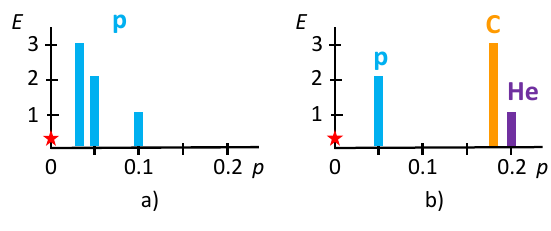
Figure 1. One dimensional sketch of a) an only energy depen- dent multiplet structure of protons with 1 / E deflection behavior and of b) a mixed composition multiplet structure where the 1 / E deflection order is not visible anymore due to the proton, helium and carbon components. The red star at p = 0 indicates the com- mon source direction.